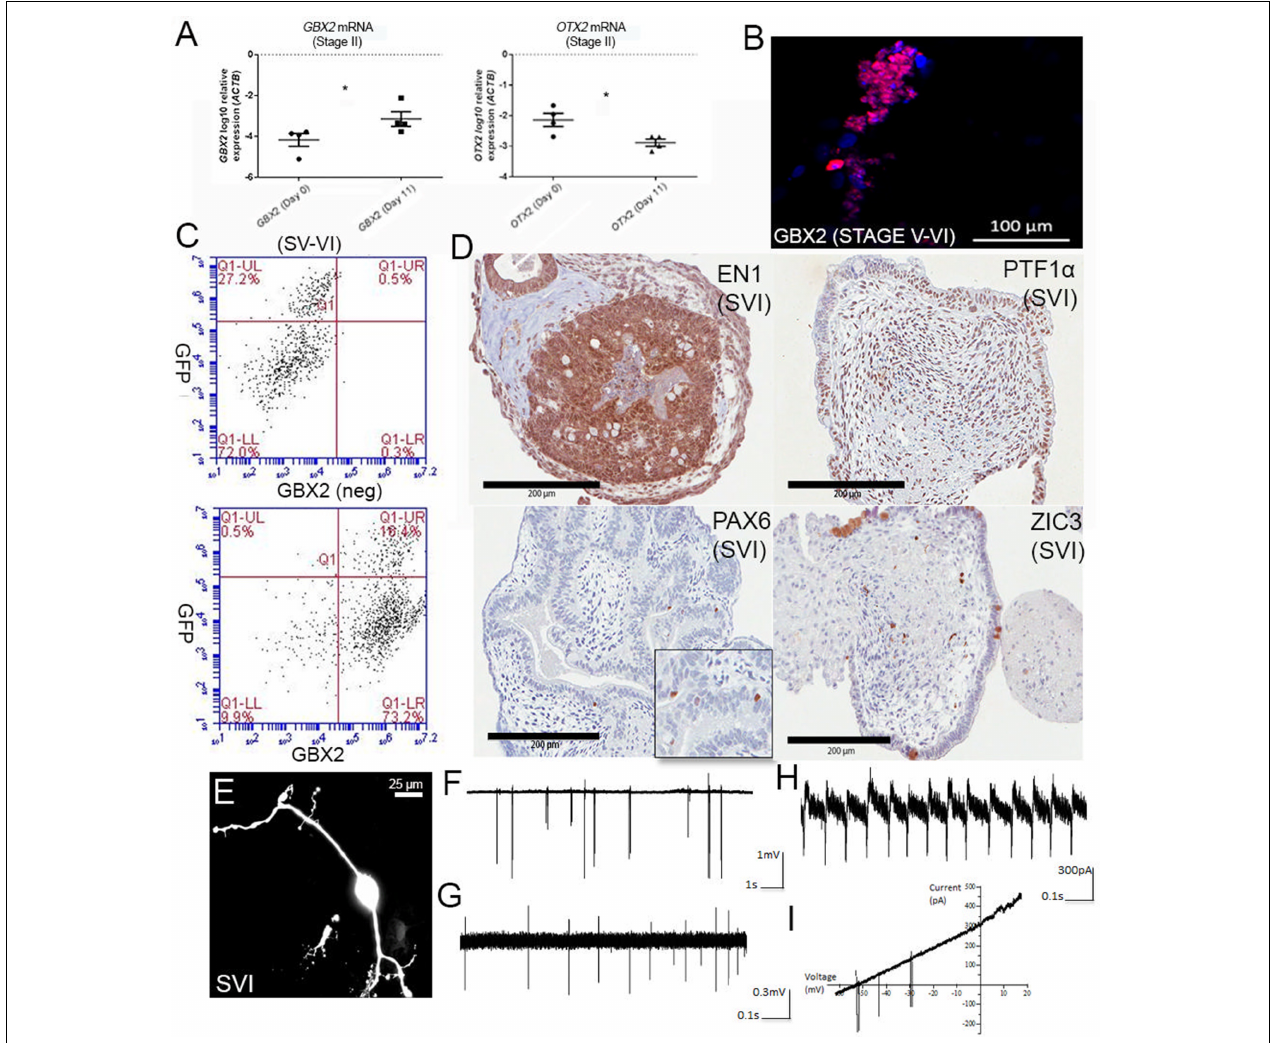
FIGURE 1 | Differentiation of cerebellar neurons. (A) Upregulation of GBX2 mRNA and downregulation of OTX2 mRNA after 11 days of differentiation. Samples were normalized to ACTB and show SEM from four independent differentiation experiments (2 iPSC, 2 hESC). ∗ Denotes statistical significance, p -values = < 0.05, unpaired t -test, Mann–Whitney. (B) Immunofluorescent labeling for GBX2 following 28 days of differentiation. Nuclei counter-stained with DAPI (scale bars are 100 µ m). (C) Flow cytometry for GBX2. Top panel shows negative control. Lower panel shows GBX2 immunolabelling in Hes3-Envy following 28 days of differentiation ( x -axis). (D) Serial sectioning and H&E staining of paraffin-embedded cell pellets following 34 days of differentiation displays reactivity with antibodies directed against hindbrain markers EN1, PTF1 α , PAX6, and ZIC3 (scale bars are 200 µ m). Inset is shown for PAX6. (E) Morphology of representative neuron following dye-filling with Neurobiotin electroporation (scale bars are 25 µ m). (F–I) Electrophysiological